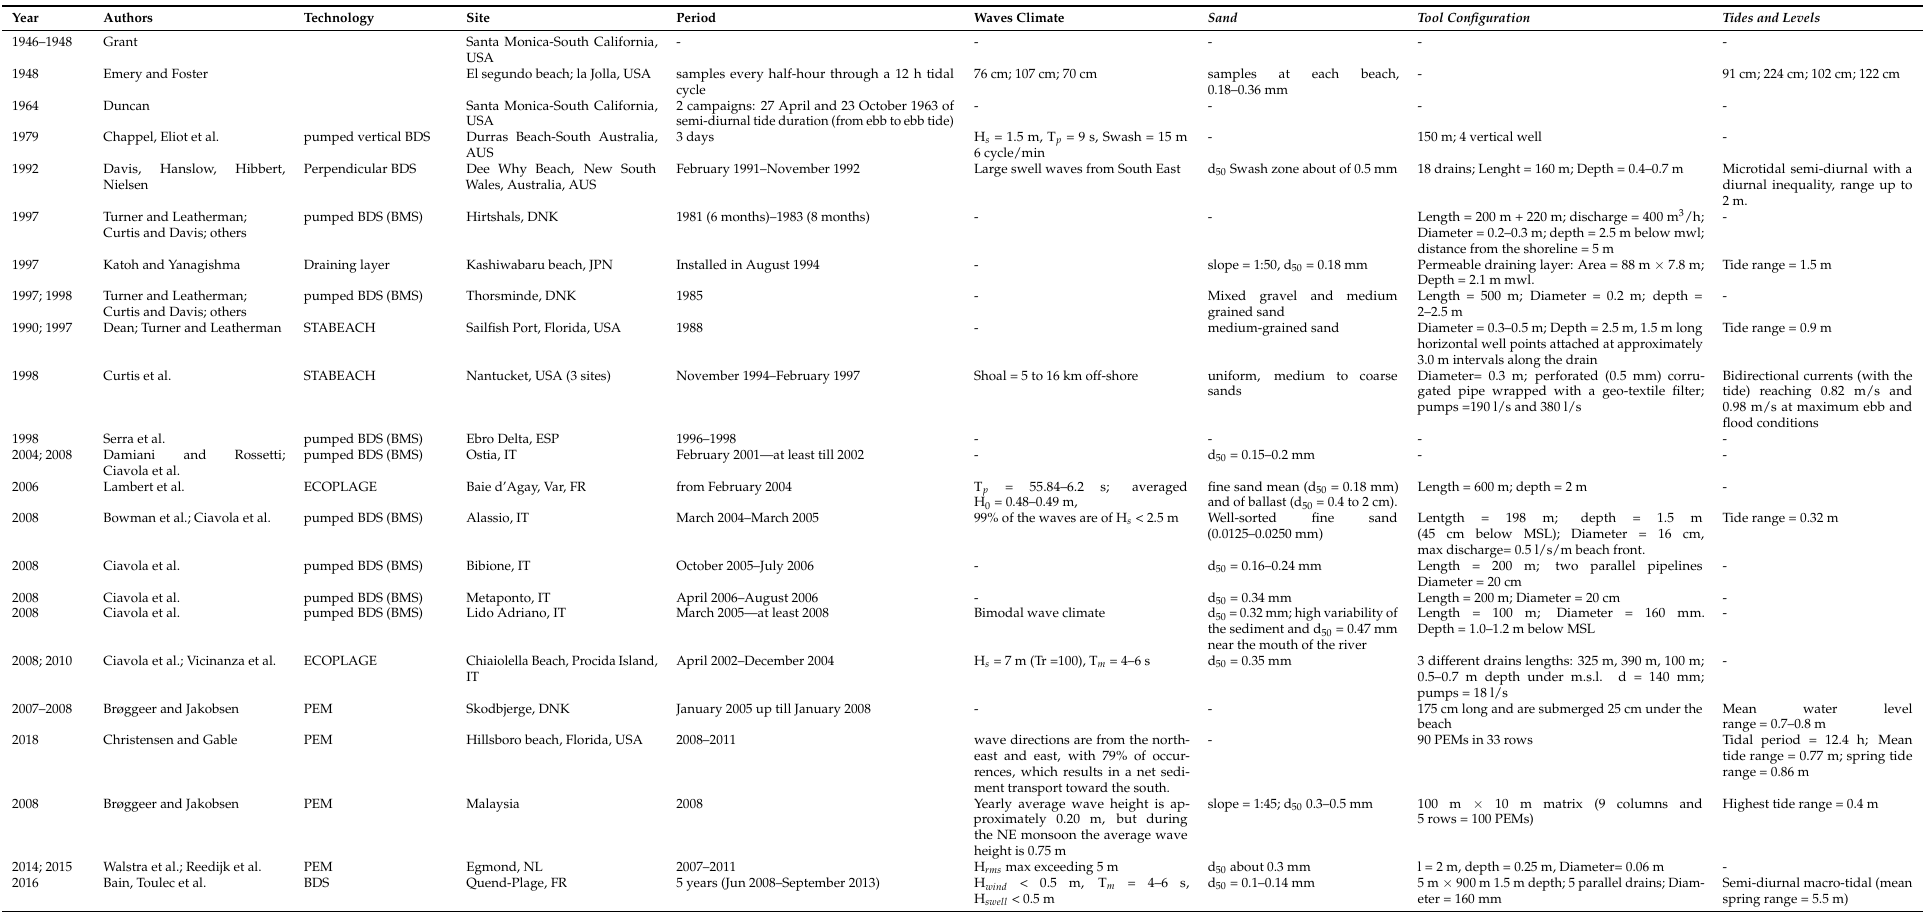
Table 2. Overview of the field experiences. In the table, d 50 is the mean diameter of the sand, T m is the mean period; T p is the peak period; H s is the significative wave height; H swell is the average swell waves height; H wind is the average waves height; H rms is the root-mean-square wave height.